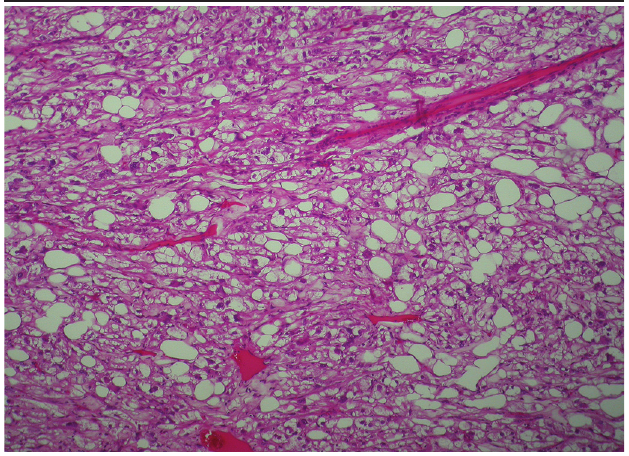
figurE 3 − Photomicrograph (HE staining, 10× objective lens): three lineages in the neoplasm – adipose cells, blood vessels and epithelioid muscle cells HE: hematoxylin and eosin.